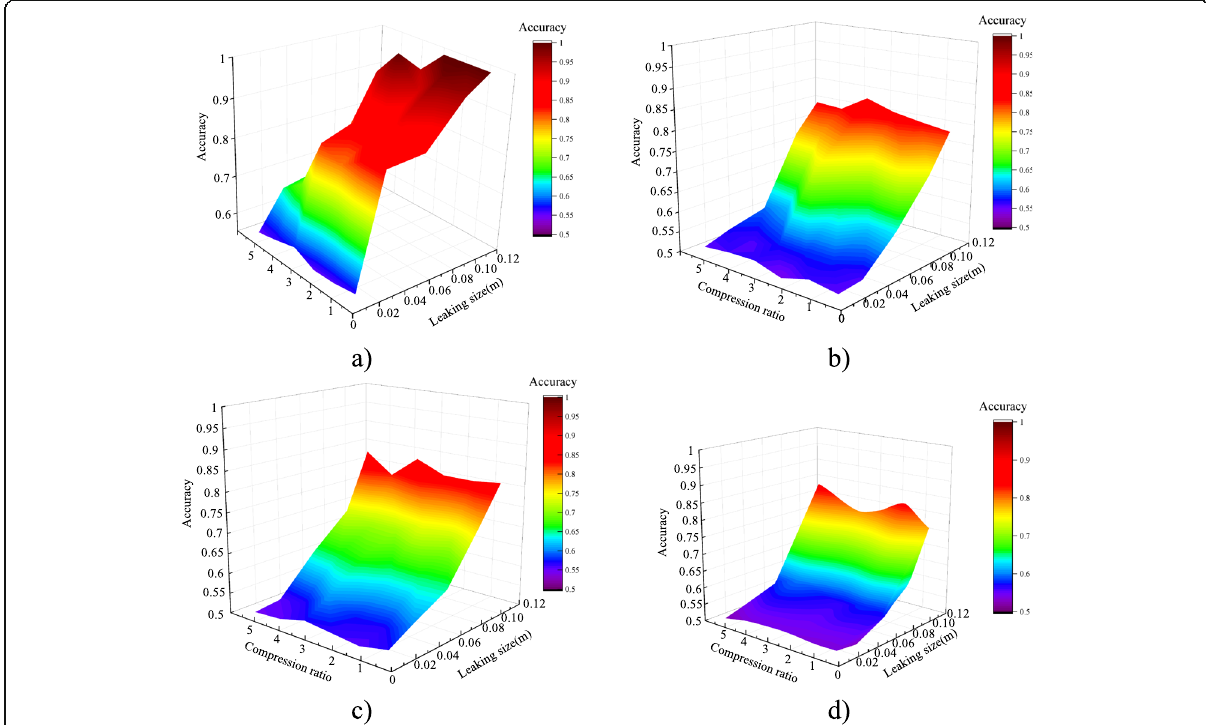
Fig. 12 The sensitivity of leak detection accuracy by AE model on the compression ratio, leak size, and water usage uncertainty: a Water usage uncertainty of N(0,0.001) L/s; water usage uncertainty of N(0,0.005) L/s, c Water usage uncertainty of N(0,0.01) L/s, d Water usage uncertainty of N(0,0.015)